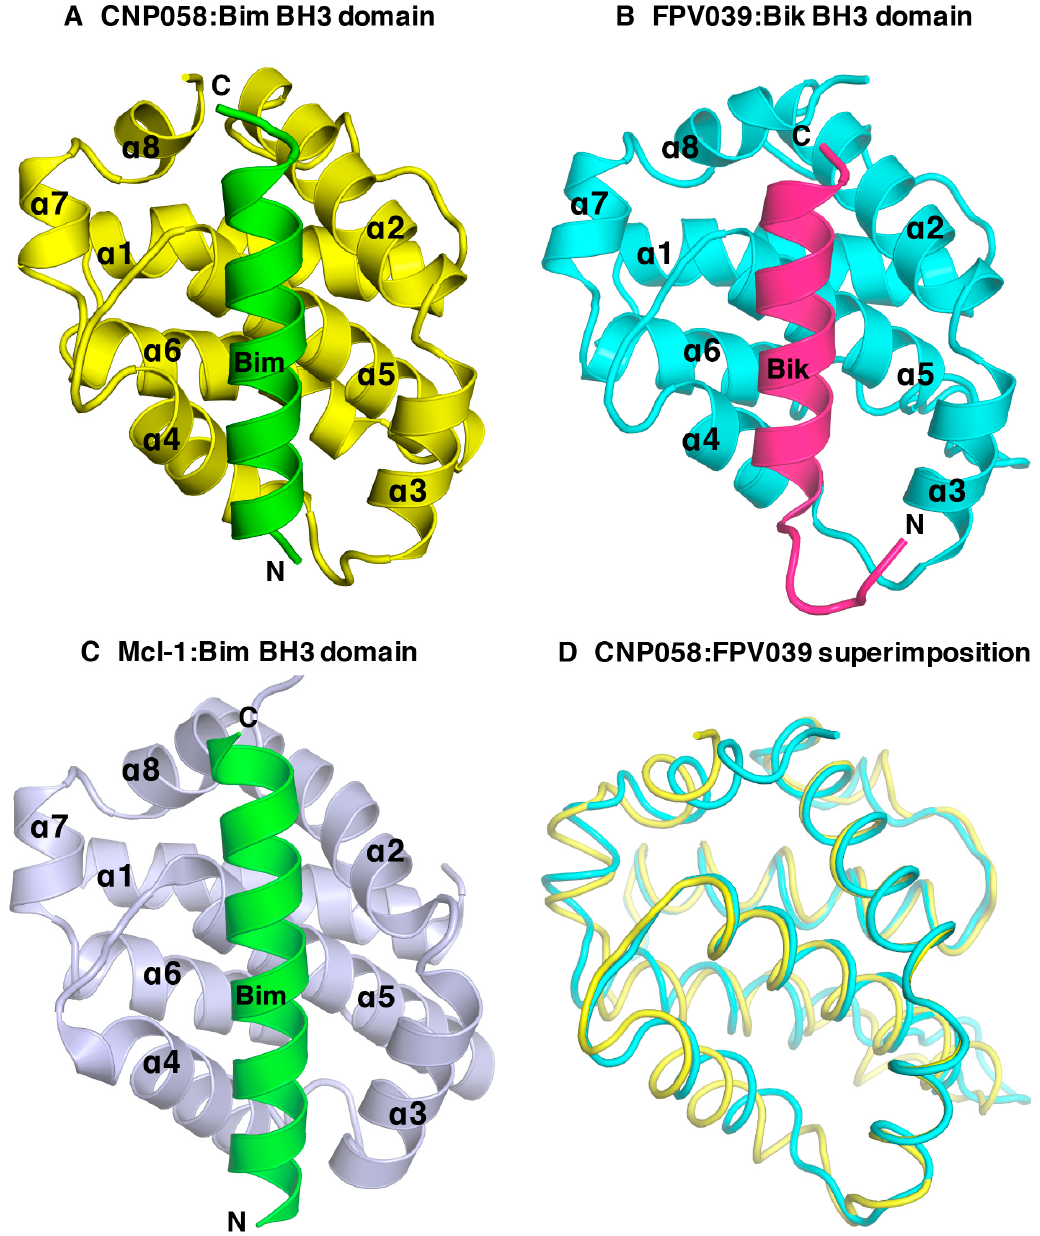
Figure 5. CNP058 interacts with pro-death Bcl-2 proteins in a BH3-domain hydrophobic groove dependent manner. ( A ) Cartoon representation of CNP058:Bim BH3 domain complex, ( B ) FPV039:Bik BH3 domain complex and ( C ) Mcl-1:Bim BH3 domain complex. The view is into the conserved hydrophobic ligand binding groove formed by α -helices 2–5. PDB ID: FPV039:Bik = 5TZP, Mcl-1:Bim = 2NL9. ( D ) CNP058:Bim complex (yellow) was superimposed onto FPV039:Bik complex (cyan). Bim and Bmf were removed from respective complex structures for clarity.